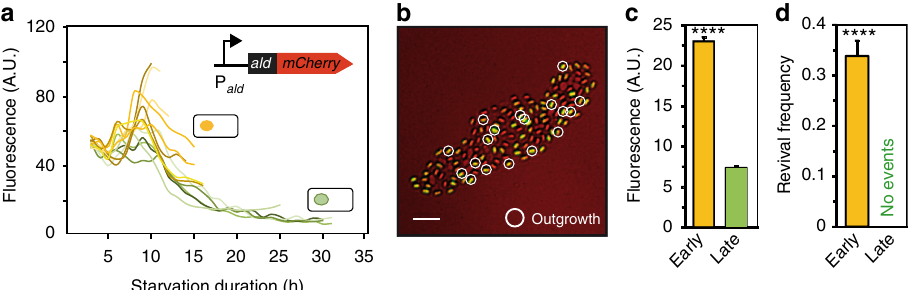
Fig. 8 Spores obtain Ald-mCherry from their progenitors. a RFP fl uorescence trajectories resulting from a Ald that was tagged with mCherry and that was expressed from the ald promoter ( amyE :: P ald -ald-mcherry). The yellow (green) lines denote trajectories of cells that turn into early (late) spores. b Overlay of a bright- fi eld (red) with a RFP fl uorescence image (green) of the resulting spores. Scale bar: 5 µ m. c Mean RFP fl uorescence of early and late spores. d Corresponding revival frequencies in response to L -alanine. Strain: BIB1423. Data: mean ± SEM, n c = 8 ( n s ≥ 500), unpaired t test: **** P ≤